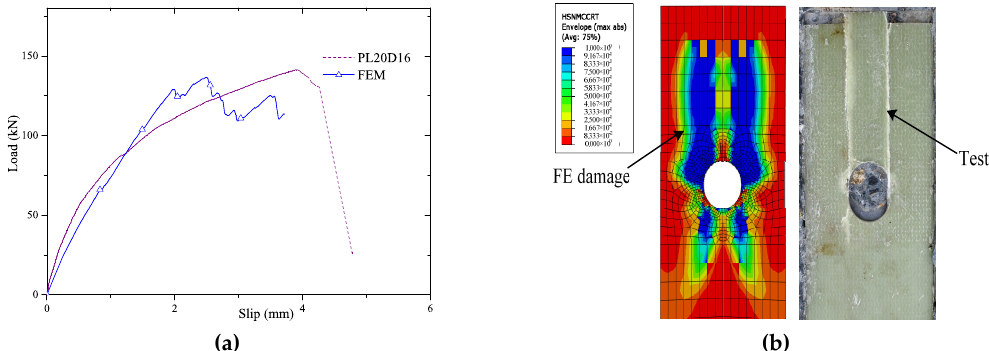
Figure 12. Verification of GFRP perforated connectors (GPC)’ FE model. ( a ): Verification of GPC’ FE model; ( b ): Failure pattern by FE vs. the test.